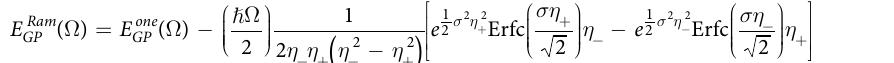
(right) we plot the effective interaction for two impurities with relative distance of one lattice site d = a (black ab Bab ( ) ( ) . line), and two sites d = 2 a (blue line), for = = − g g g / 1 A